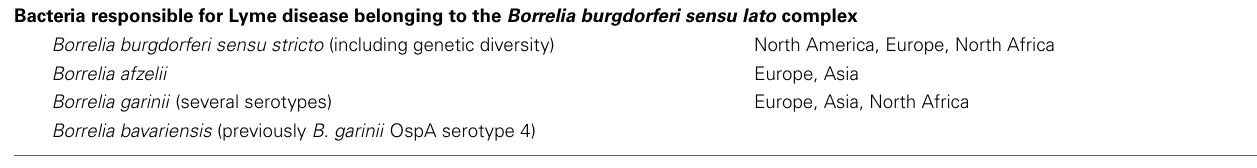
Table 1 | Bacteria responsible for Lyme or Lyme-like disease and other Borrelia sp. belonging to the Borrelia burgdorferi sensu lato complex, and other tick-borne micro-organisms isolated in